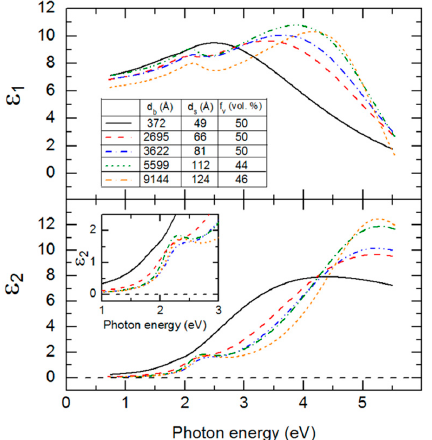
Figure 9. Plots of the analytical expressions for the ( ε 1 , ε 2 ) spectra of an IGS thin film with x = 0.30 obtained by fitting the spectra deduced by inversion at the centers of five different time ranges used in the multi-time analysis of RTSE data. A table is included in the upper panel that provides the bulk layer thickness, surface roughness layer thickness and void volume percentage in the roughness layer at the center time of each analysis range. The inset of the lower panel depicts the onset in ε 2 near the fundamental bandgap, represented by the CP resonance energy. All ( ε 1 , ε 2 ) spectra depicted here are relevant for the substrate temperature of 400 °C. Among the ten parameters that could be varied, namely five for the CP oscillator, four for the TL oscillator and the constant ε 1 ∞ , only six are varied. The CP phase and exponent are fixed at 0° and